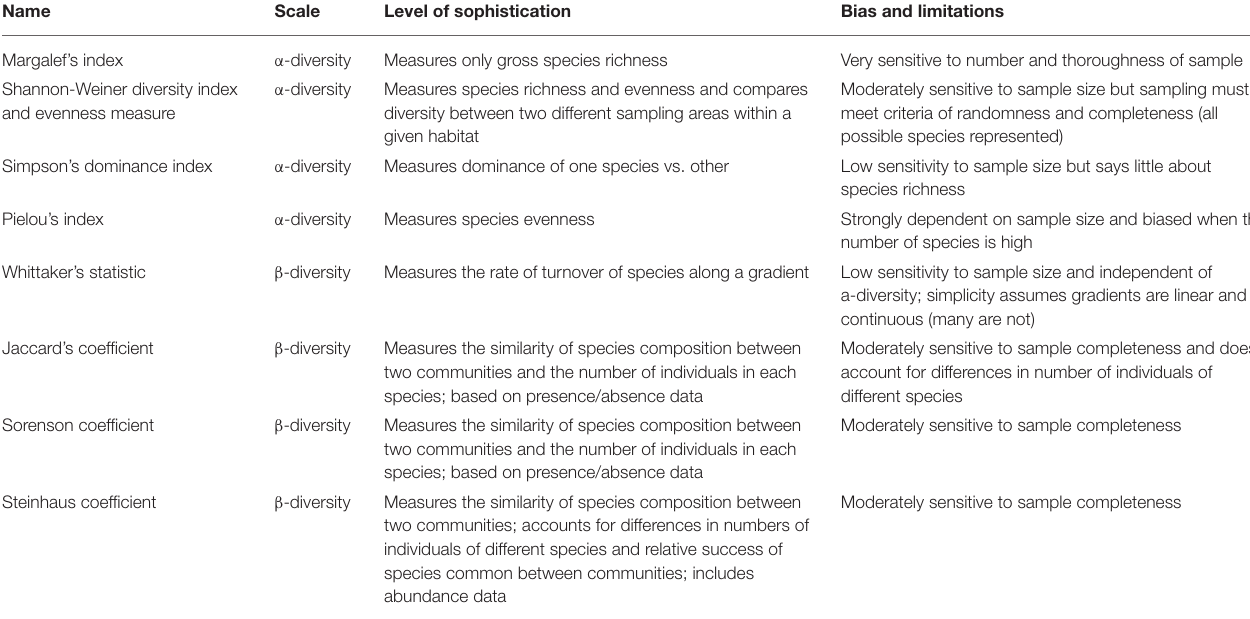
TABLE 1 | Comparing the scale, sophistication, biases and limitations of diversity measures discussed above (modified from Booth et al., 2003,